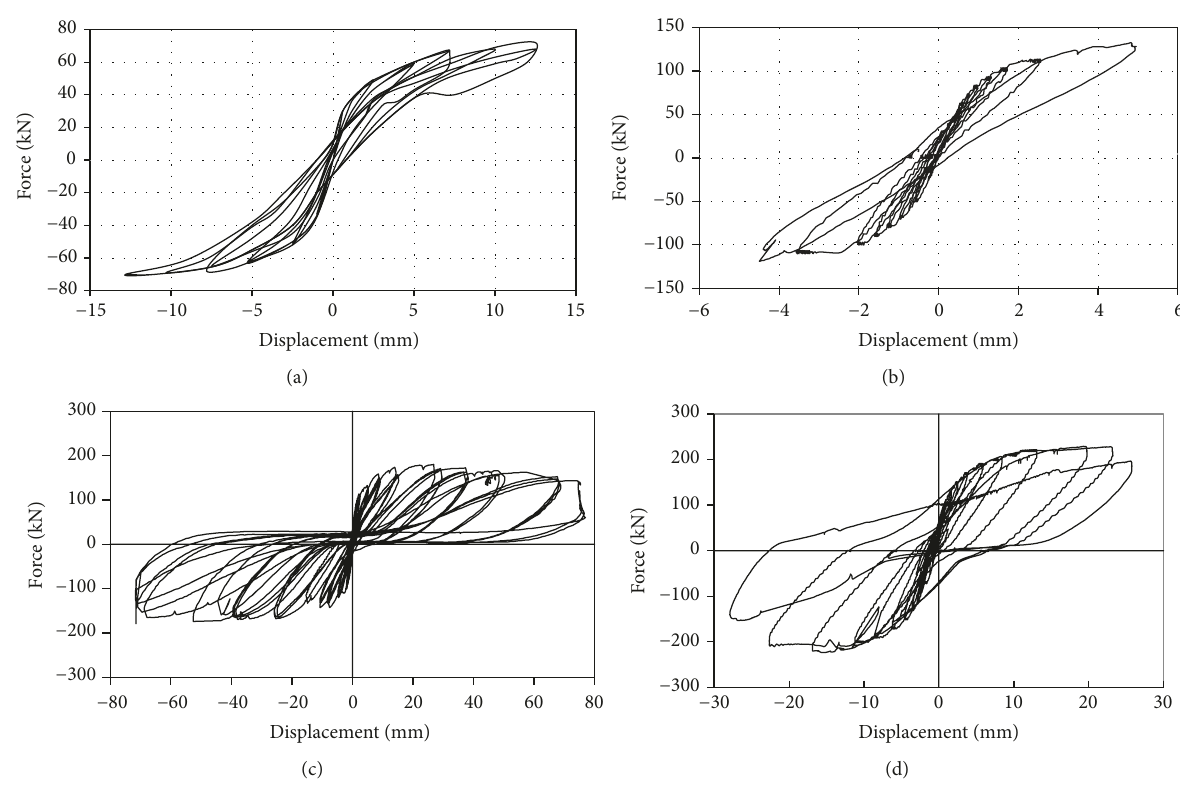
Figure 14: Hysteresis loop according to Anthoine et al. (a) and those of the specimens ((b) is that found in the earlier stage, (c) is the whole curve of specimen 1TB2, and (d) is the curve of specimen